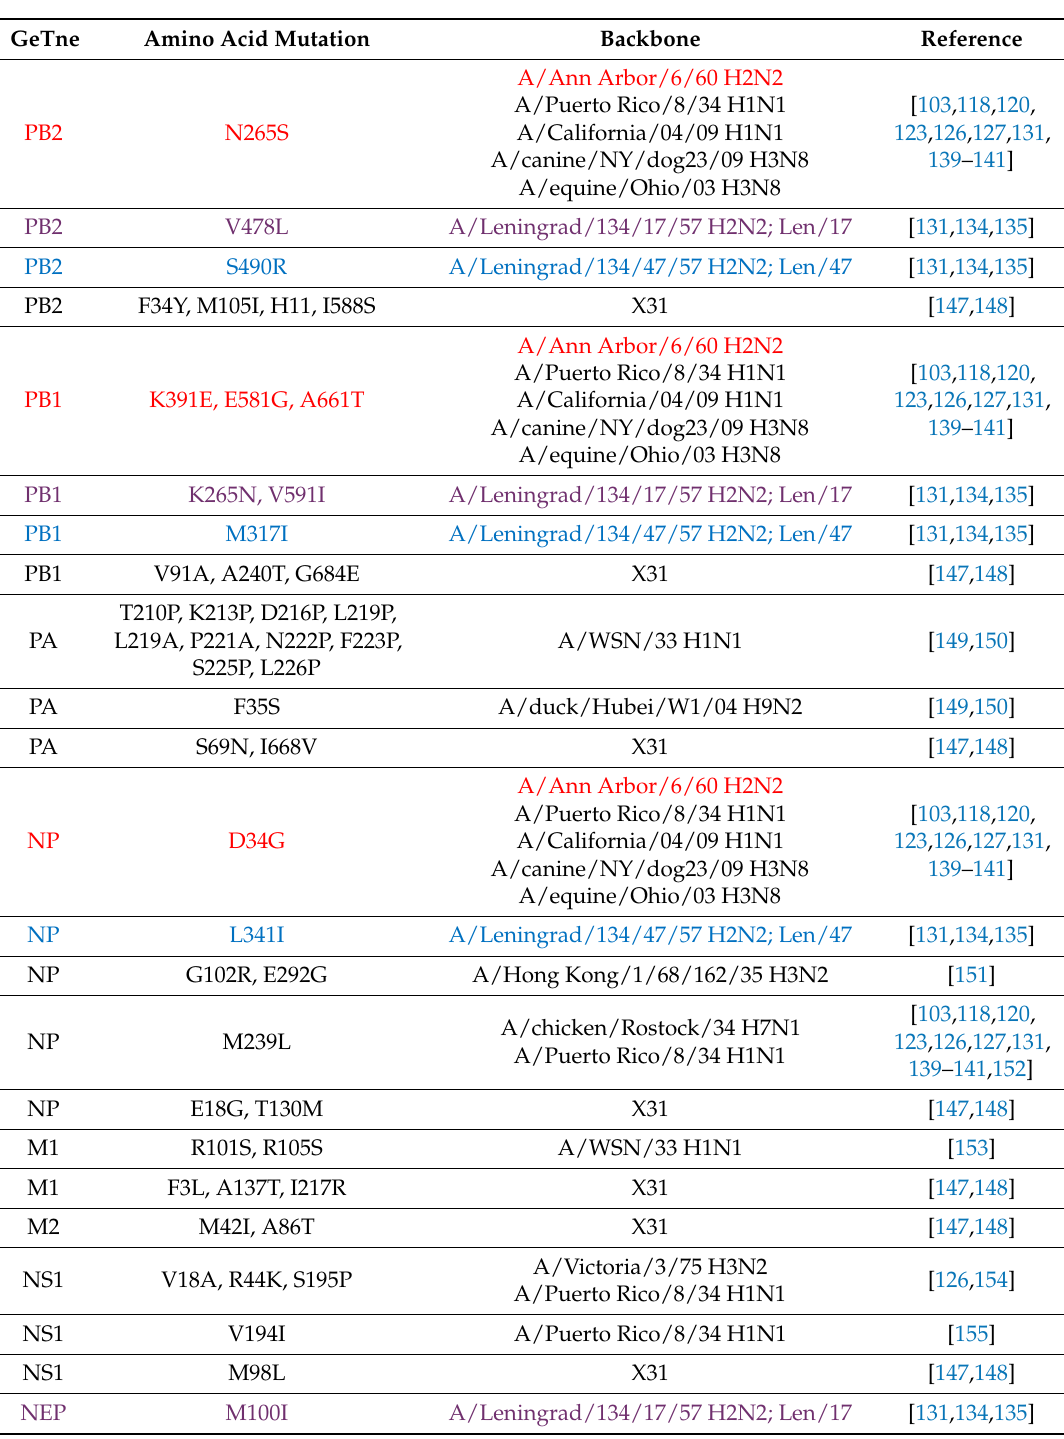
Table 1. Amino acid mutations in IAV polymerase complex associated with a temperature sensitive phenotype. Amino acid substitutions of the US MDV A/Ann Arbor/6/60 H2N2 (red), the Russian MDV A/Leningrad/134/17/57, Len/17 (magenta) and the Russian MDV A/Leningrad/134/47/57, Len/47 (blue) H2N2 LAIVs are indicated (for more information see Figure